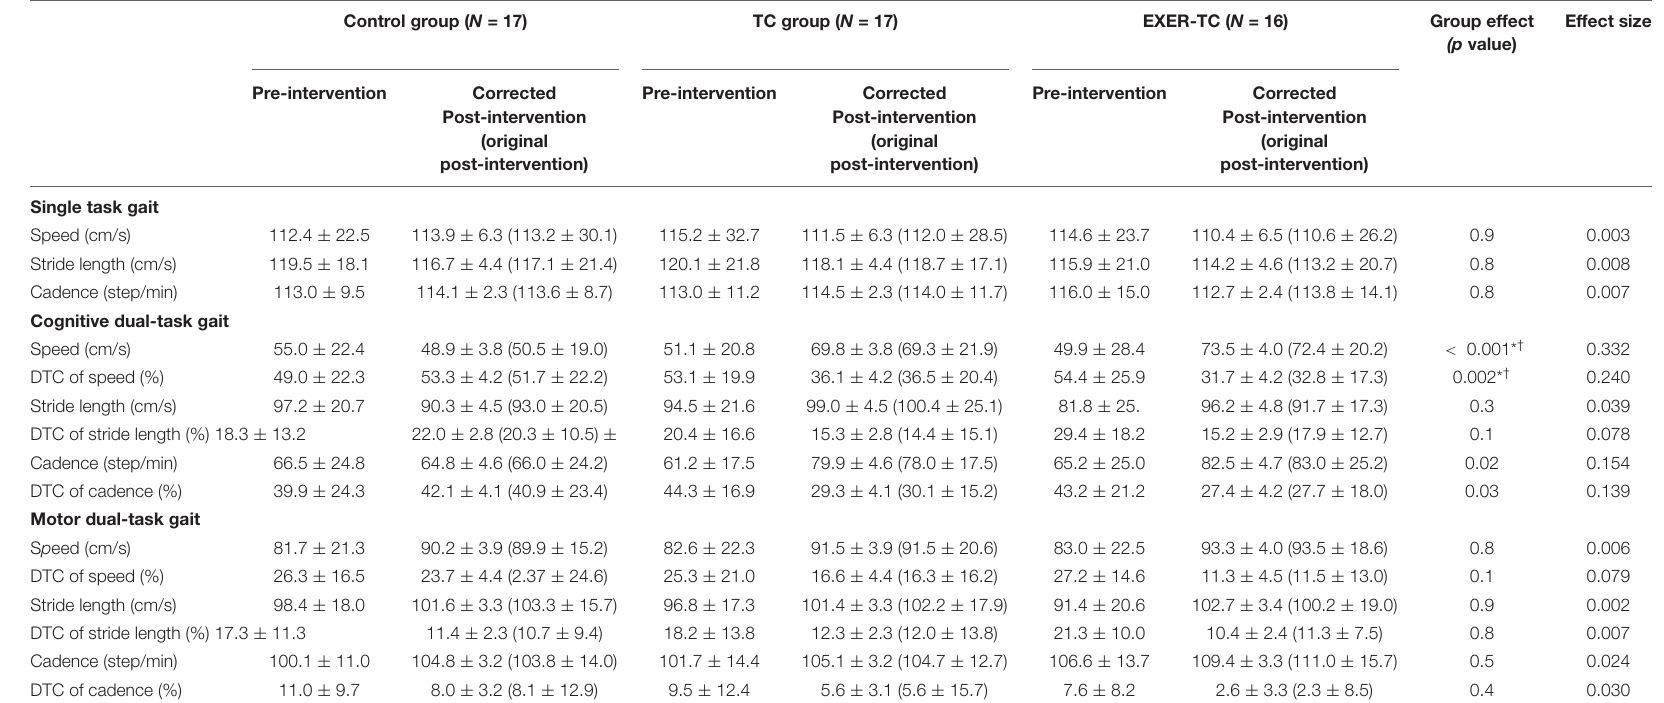
TABLE 3 | The ANCOVA analysis and post hoc comparisons of dual-task gait performance between control group, TC group, and EXER-TC group after 36 training sessions ( N =